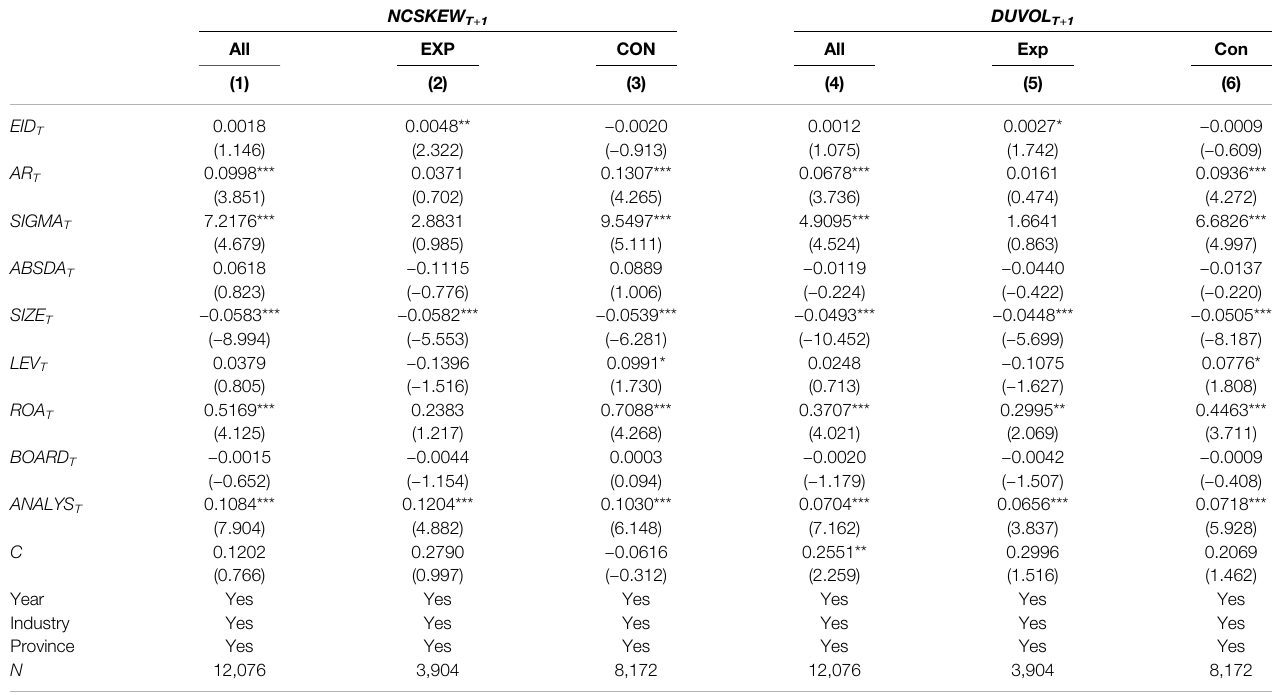
TABLE 3 | Effect of environmental information disclosure